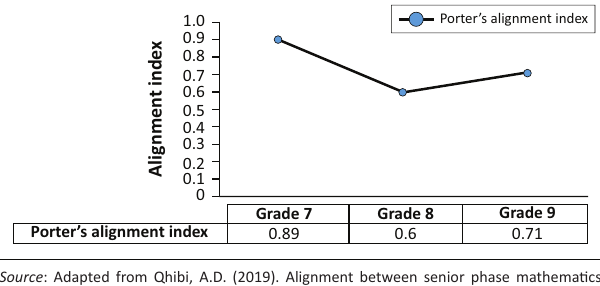
FIGURE 3: Grades 7–9 alignment indices between Senior Phase Mathematics Content Standards and numeric and geometric patterns workbook